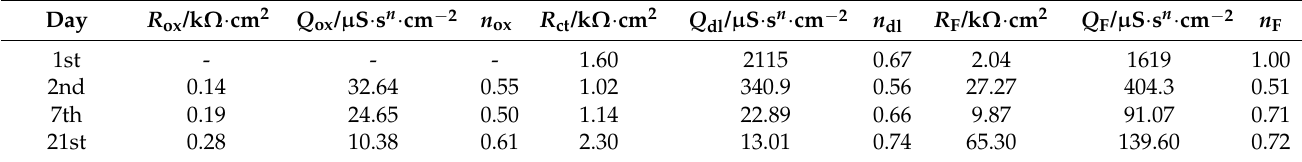
Table 4. EIS data for RG7 for continuous immersion in simulated acid rain at pH 5.